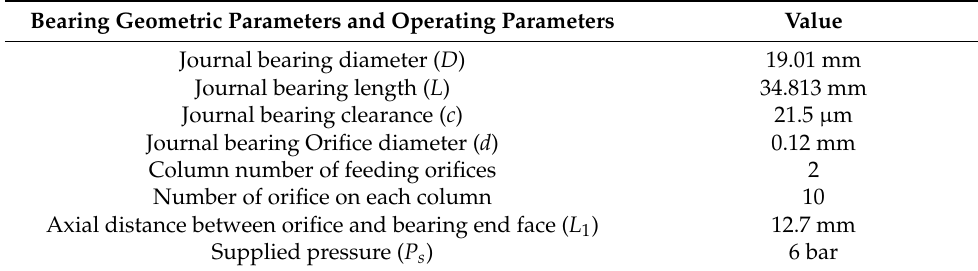
Table 1. Bearing geometric parameters and operating parameters in this study.